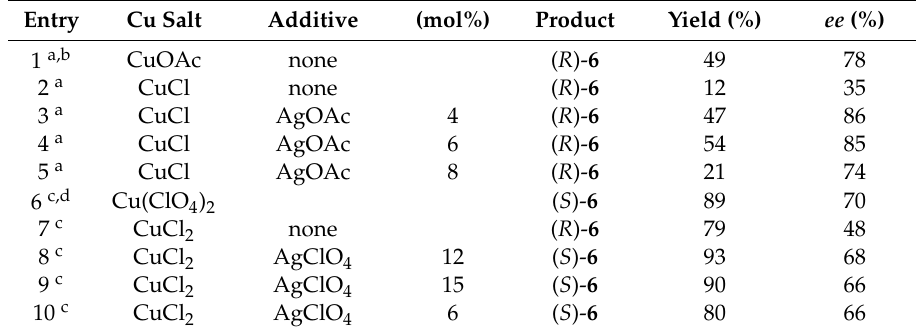
Table 6. Switching of stereoselectivity in the CuCl n -catalyzed conjugate addition reaction of 5 in the presence of an